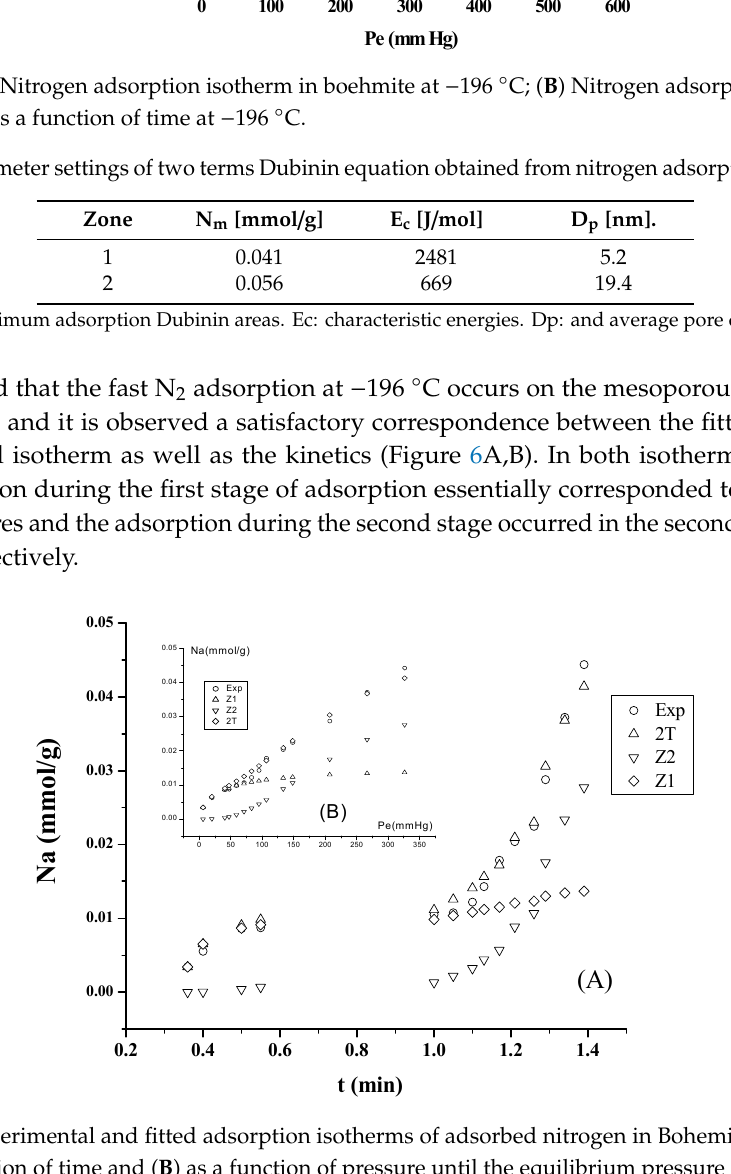
Figure 6. Experimental and fitted adsorption isotherms of adsorbed nitrogen in Bohemite at − 196 °C: ( A ) as a function of time and ( B ) as a function of pressure until the equilibrium pressure of 325 mmHg (Experimental Isotherm (Exp), setting of Dubinin Zone 1 (Z1), setting of Dubinin Zone 2 (Z2) and setting for two terms of Dubinin (2T)).